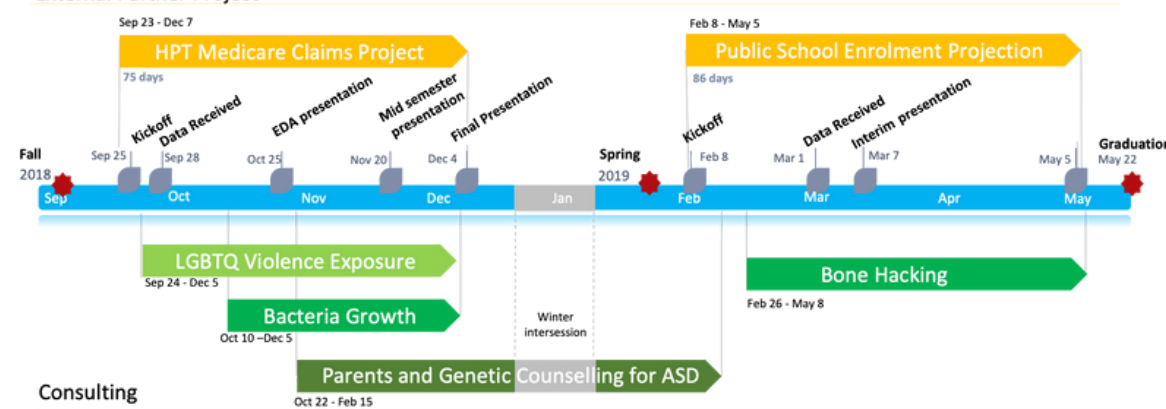
Figure 3. Visual depiction (in the form of an annotated timeline) of student effort on projects with external partners (shown in yellow) during the year—one during each of the fall and spring semesters. Partner projects are planned by faculty in the months prior to each semester. Students also work throughout the academic year on typically four to six statistical consulting projects with university researchers (shown in green), for which the start/stop, topic, and scope are all variable. (Note. Details by way of projects and specific dates, naturally, change year to